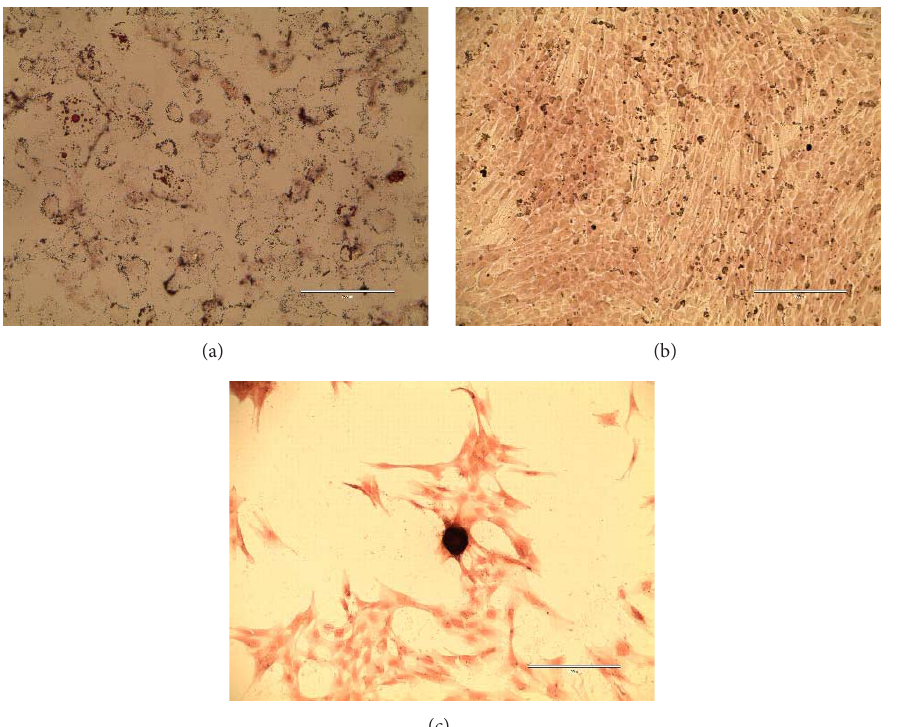
Figure 8: Differentiated hUC MSCs. (a) Adipocytes stained with Oil Red after 21 days (scale bar = 200 𝜇 m); (b) osteocytes stained with Alizarin Red; and (c) chondrocytes stained with Safranin after 22 days (scale bar = 400 𝜇